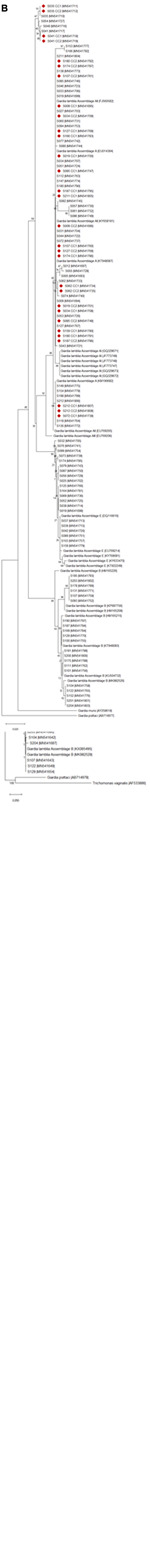
Phylogenetic tree of the Giardia lamblia isolates collected from children before and after treatment, by the neighbor-joining algorithm using a Kimura two-parameter. (A) Phylogenetic tree based on sequences of the glutamate dehydrogenase gene. (B) Phylogenetic tree based on sequences of the beta-giardin gene. The name sequences are indicated by their accession numbers. Red diamond: CC1: isolate from sample of first cure control, and CC2: isolate from sample of second cure control.